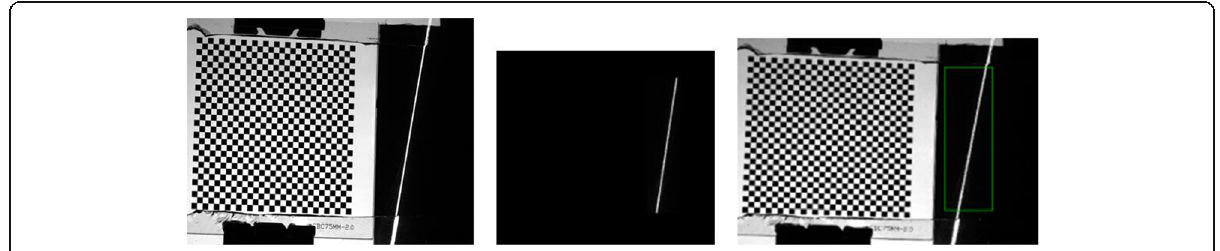
Fig. 7 The light stripe matching process. a Coplanar target. b Light stripe template. Matched light stripe